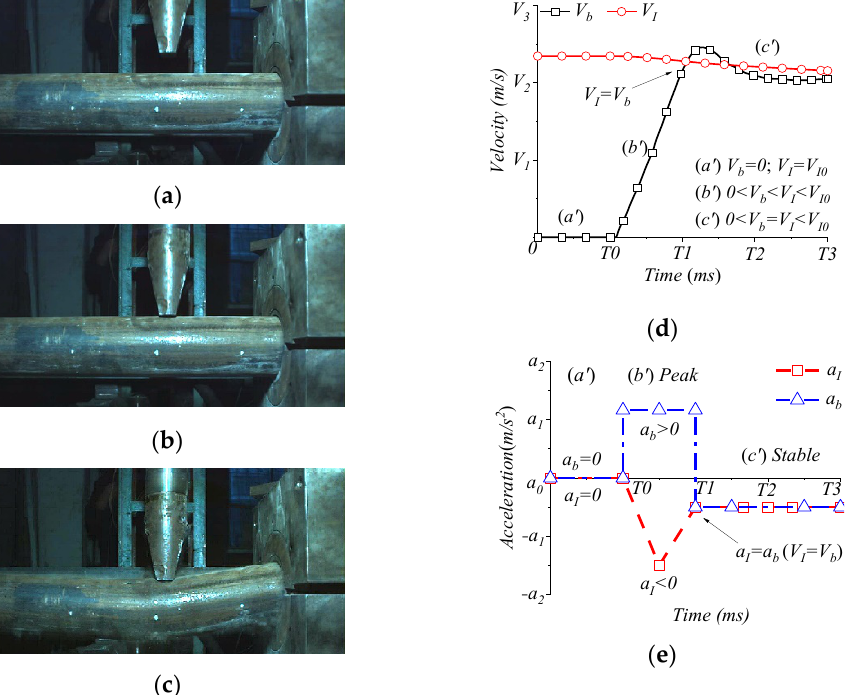
Figure 7. Contact relationship. ( a ) Before impacting; ( b ) Initial peak stage; ( c ) Stable stage; ( d ) Velocity; ( e ) Acceleration.